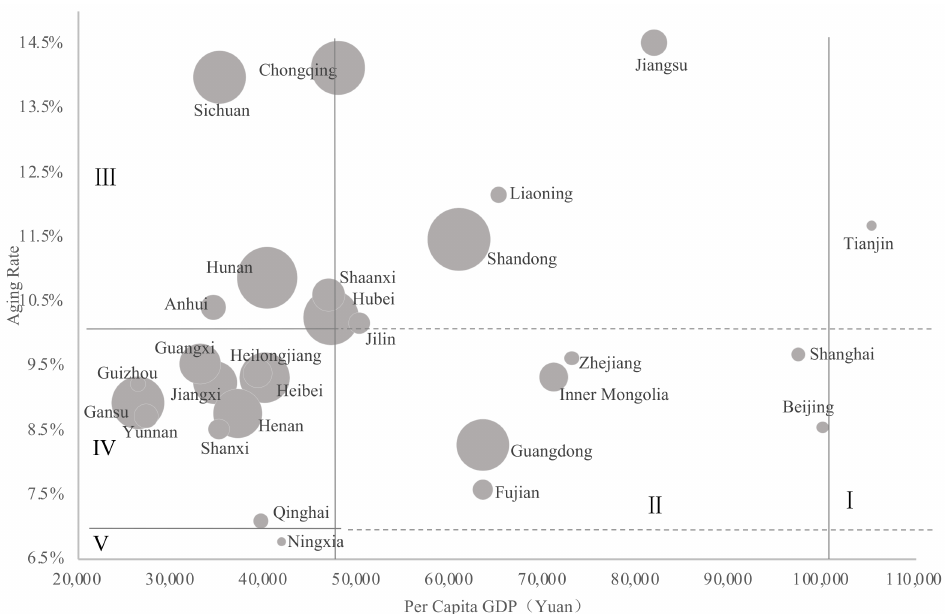
Figure 3. The scale of multiple vulnerable older adults in different